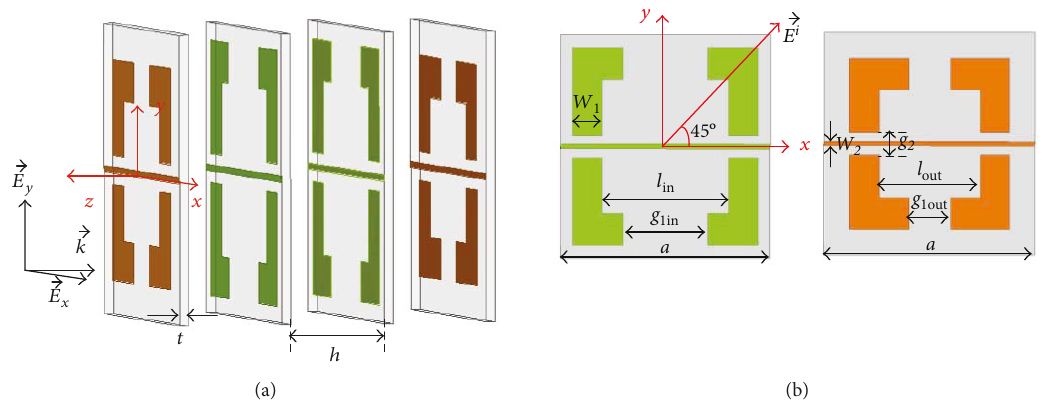
Figure 1: (a) The unit cell of the proposed circular polarizer. (b) Di ff erent geometry of the layers.